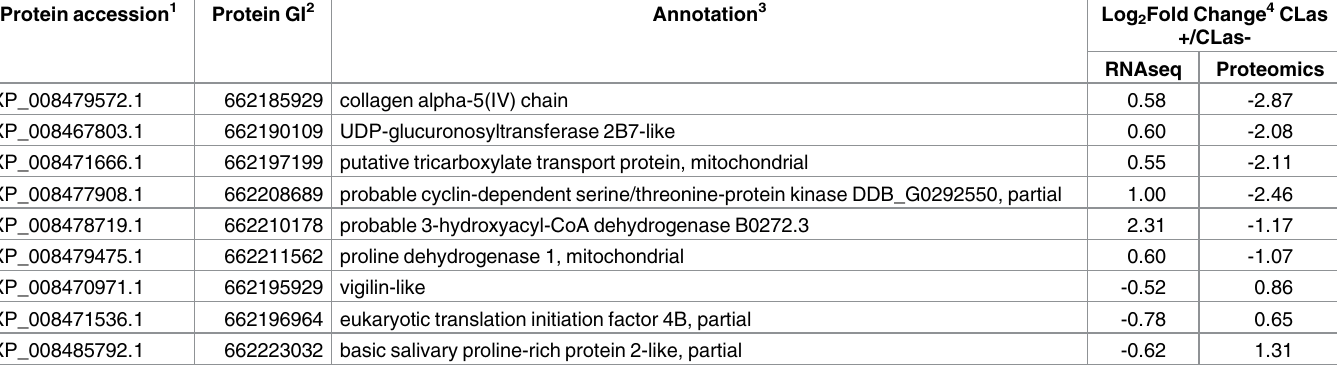
Table 3. ACP proteins with antiparallel patterns of regulation between the transcriptome and proteome. Protein accession 1 Protein GI